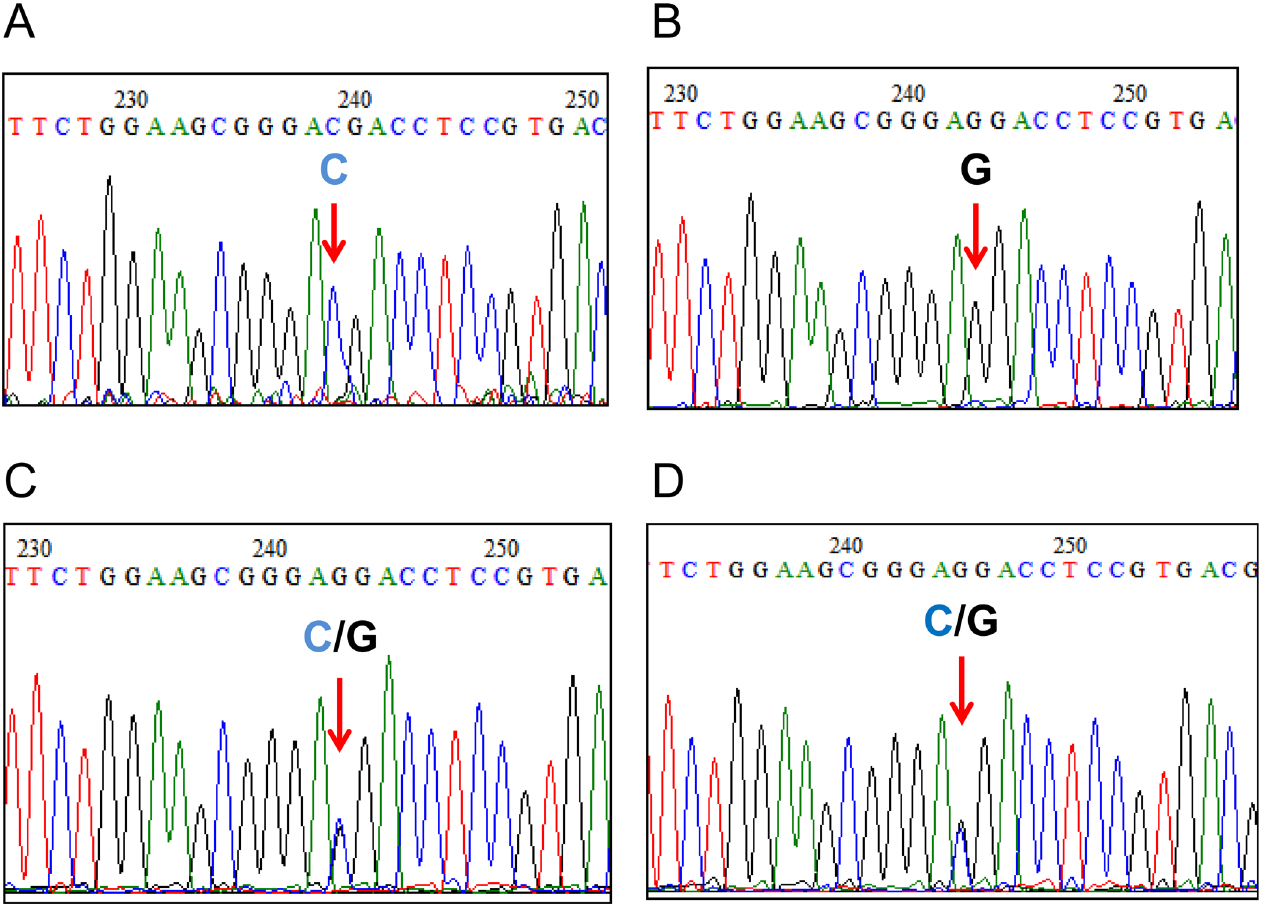
Fig 3. Direct sequence analysis showing a species-specific polymorphic site of Leishmania MPI gene fragments. A. L . (V . ) braziliensis , B. L . (V . ) peruviana , C. a hybrid of L . (V . ) braziliensis/L . (V . ) peruviana strain LH1099, D. Leishmania- positive Lu . tejadai 13Hua3-1E.